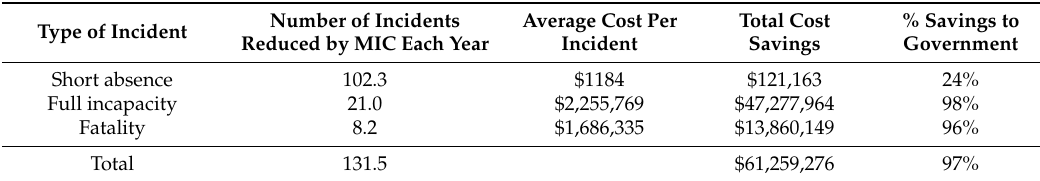
Table 7. Potential economic savings of a workplace suicide prevention strategy in one year.